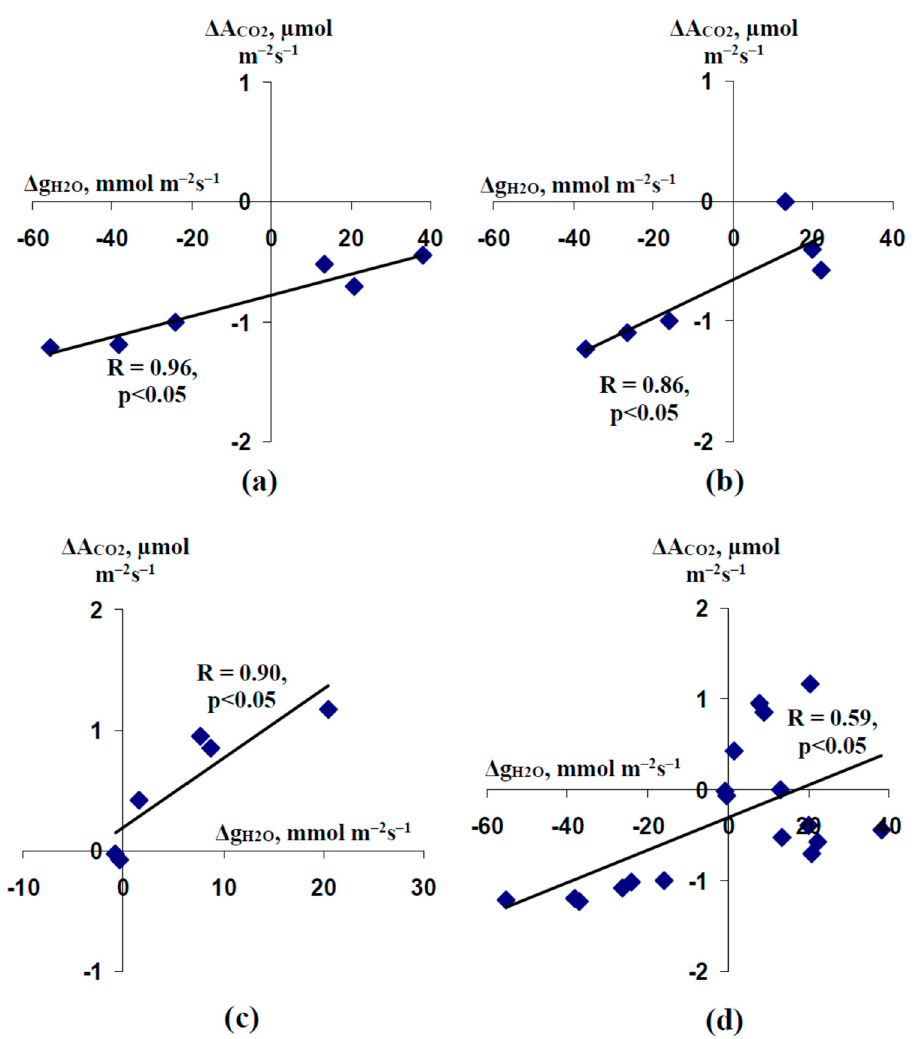
Figure 8. Dependences of burning-induced changes in the photosynthetic CO 2 assimilation ( ∆ A CO2 ) on changes in the leaf stomatal conductance ( ∆ g H2O ) in control pea seedlings ( n = 6) ( a ), seedlings after 2 days of soil water shortage ( n = 6) ( b ), seedlings after 4 days of water shortage ( n = 6) ( c ), and all investigated seedlings ( n = 18) ( d ). R is the linear correlation coefficient.